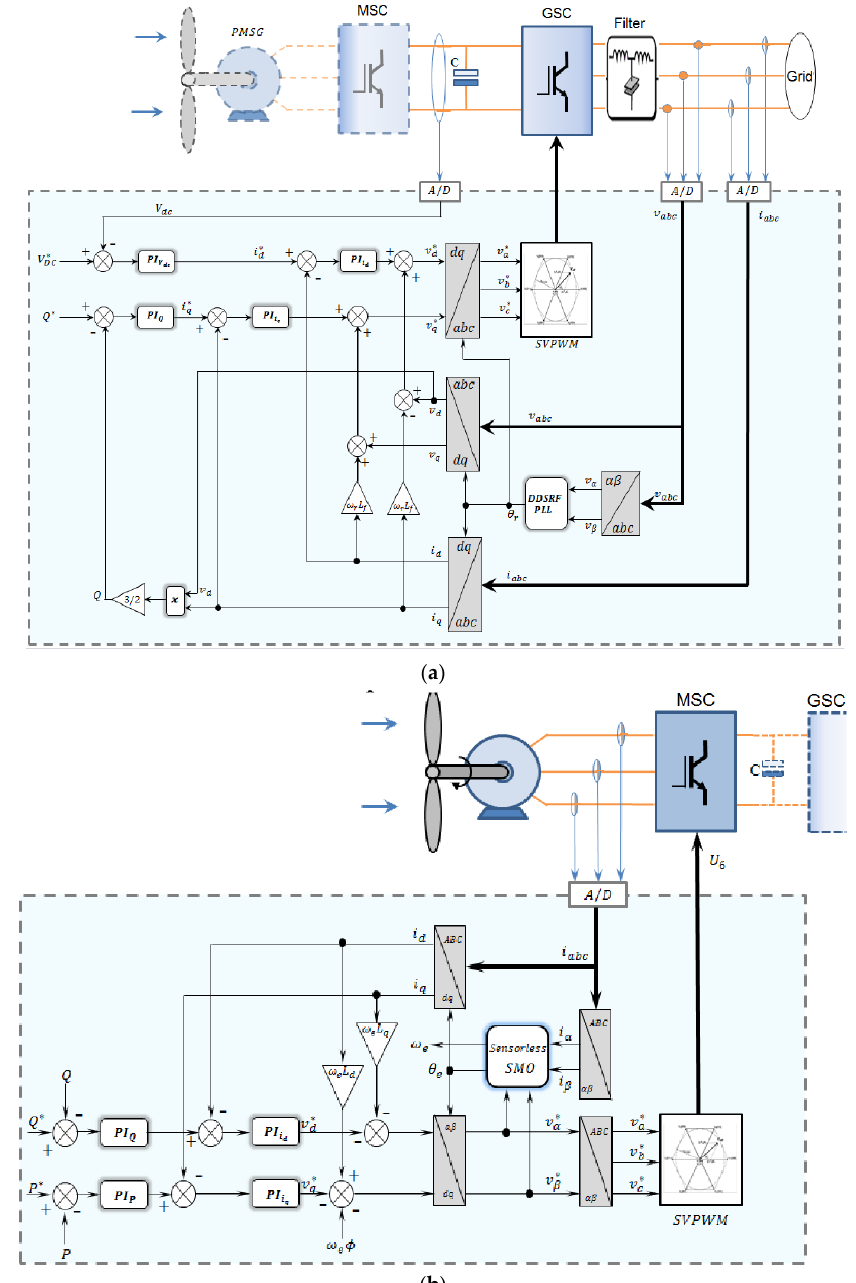
Figure 3. Control block diagram of the ( a ) grid side converter (GSC) and ( b ) machine side converter (MSC). Sliding mode observer: SMO.